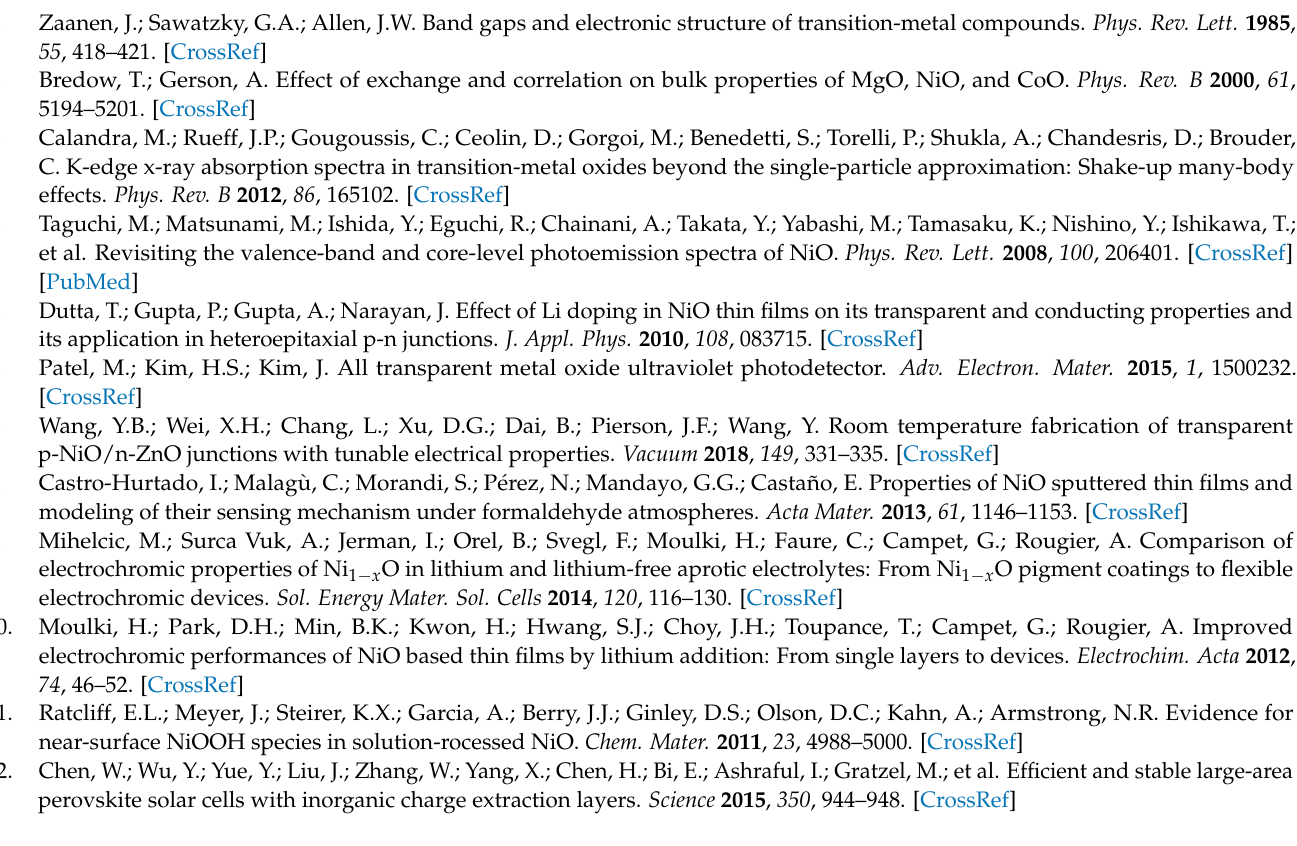
the oxygen flow rate, Figure S2: O1 s XPS spectra of various NiO thin films deposited with different oxygen flow rates, Figure S3: RBS spectra of NiO thin film grown with 11 sccm O 2 , Figure S4: Ni 2 p 3/2 XPS spectra of NiO thin films deposited with different oxygen flow rates (4, 7 and 11 sccm O 2 ), Figure S5: O K edge ELNES spectra of various NiO thin films deposited with different oxygen flow